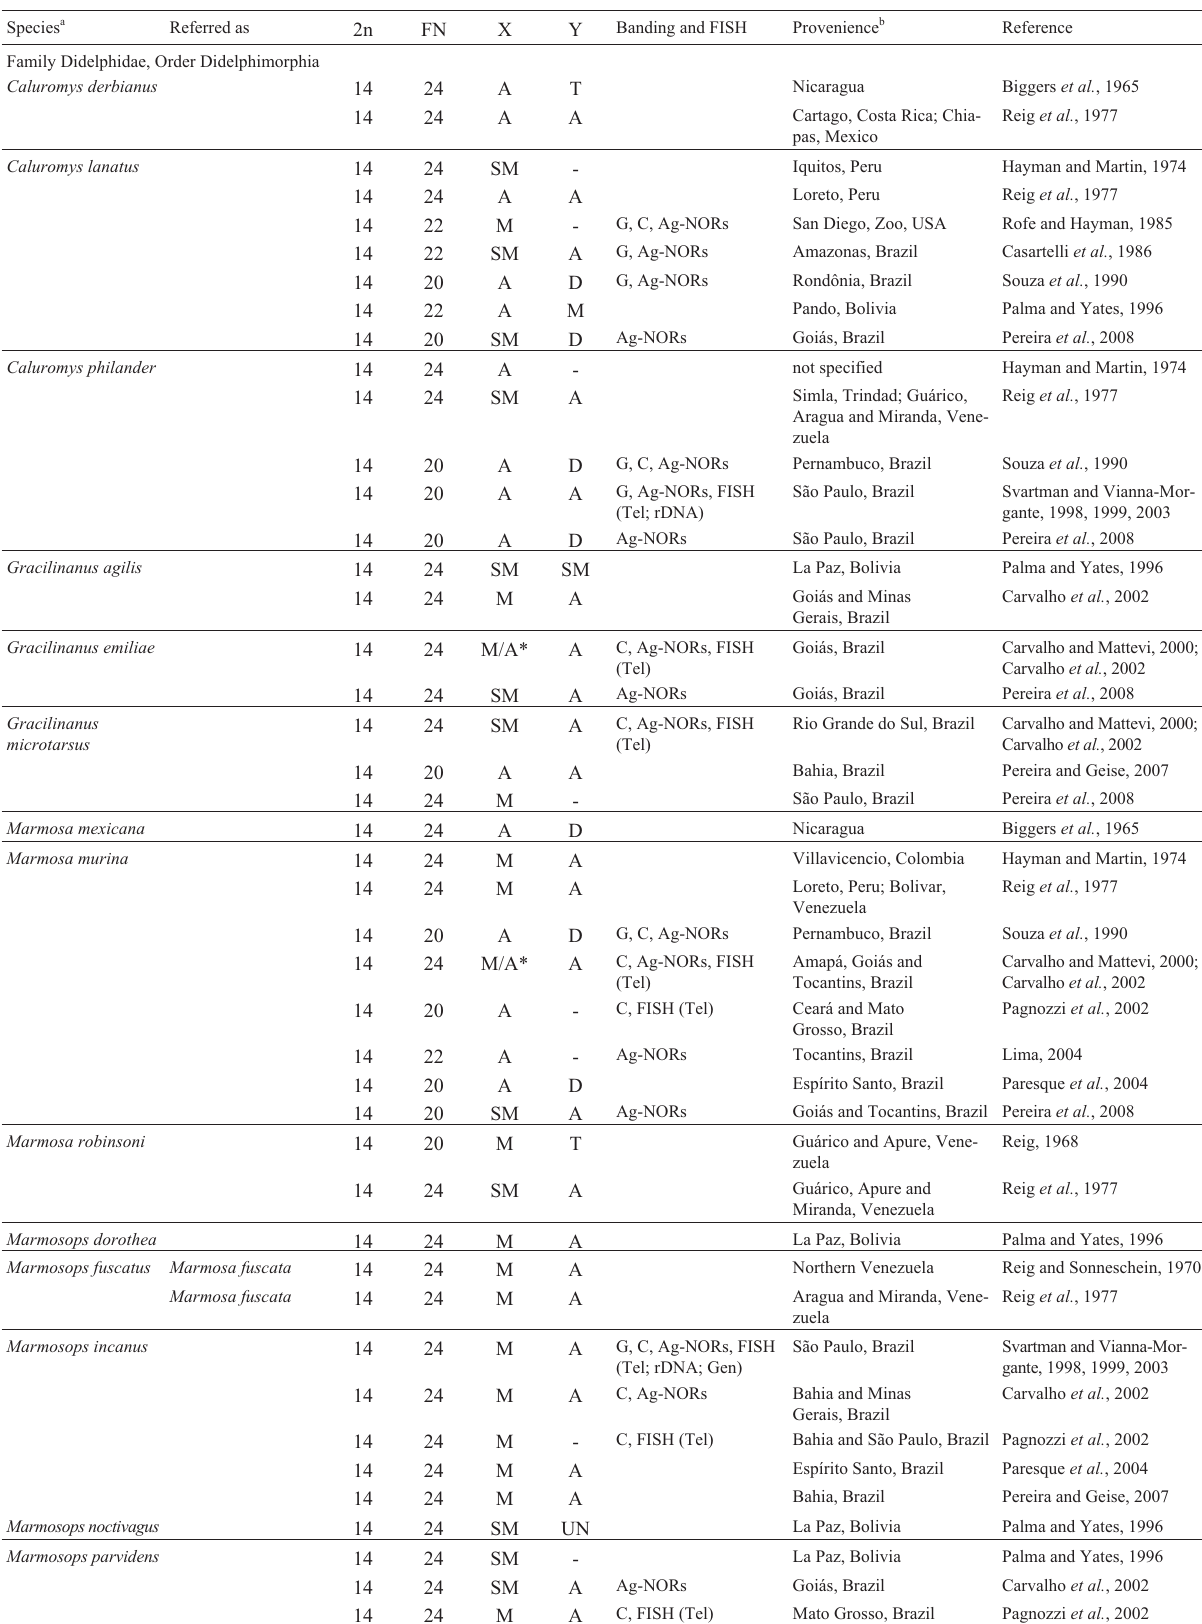
Table 1 - American marsupial species karyotyped. Species